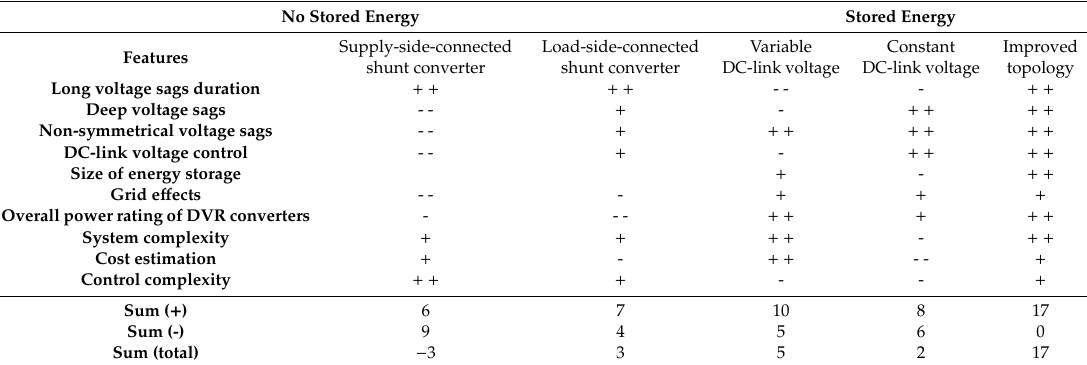
Table 1. Comparison of the di ff erent DVR topologies with the grading: very good ( + + ), good ( + ), poor (-), and very poor (-